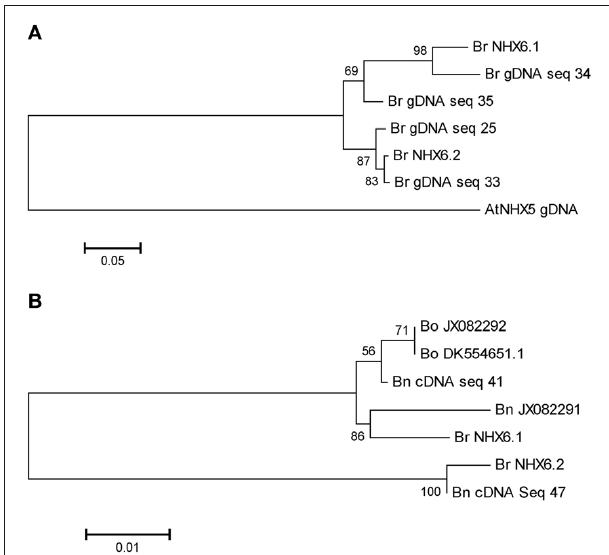
FIGURE 6 | Phylogenetic analysis of B. rapa , B. oleracea, and B. napus NHX6 partial sequences. B. rapa gDNA (A) and B. rapa , B. oleracea and B. napus mRNA (B) sequences were aligned using Clustal W, and a Neighbor-joining tree generated. Numbers at nodes correspond to bootstrap support percentages following 1000